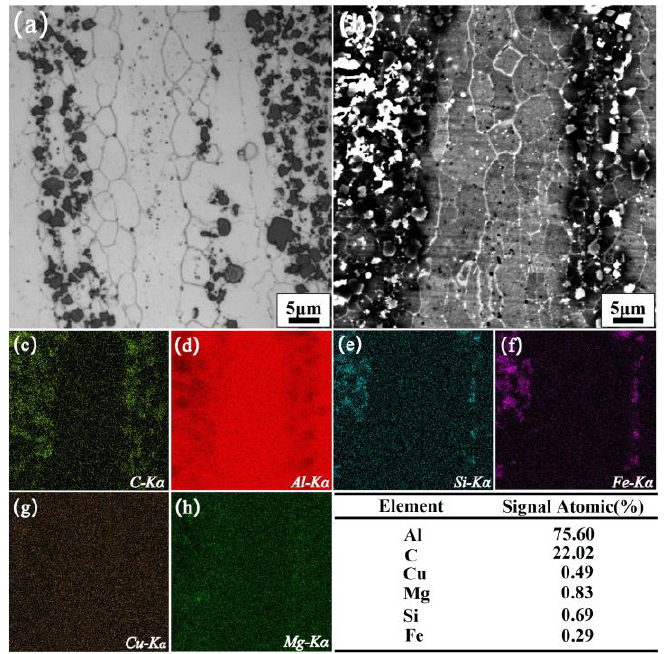
Figure 6. Microstructure of as hot-extrusion 1.5 wt% CNT/Al-Cu-Mg-Si composite. ( a ) OM image of macrostructure, ( b – h ) SEM back-scattered electron image (Determine the distribution of C, Al, Si, Fe, Cu, Mg by scanning the EDS surface).